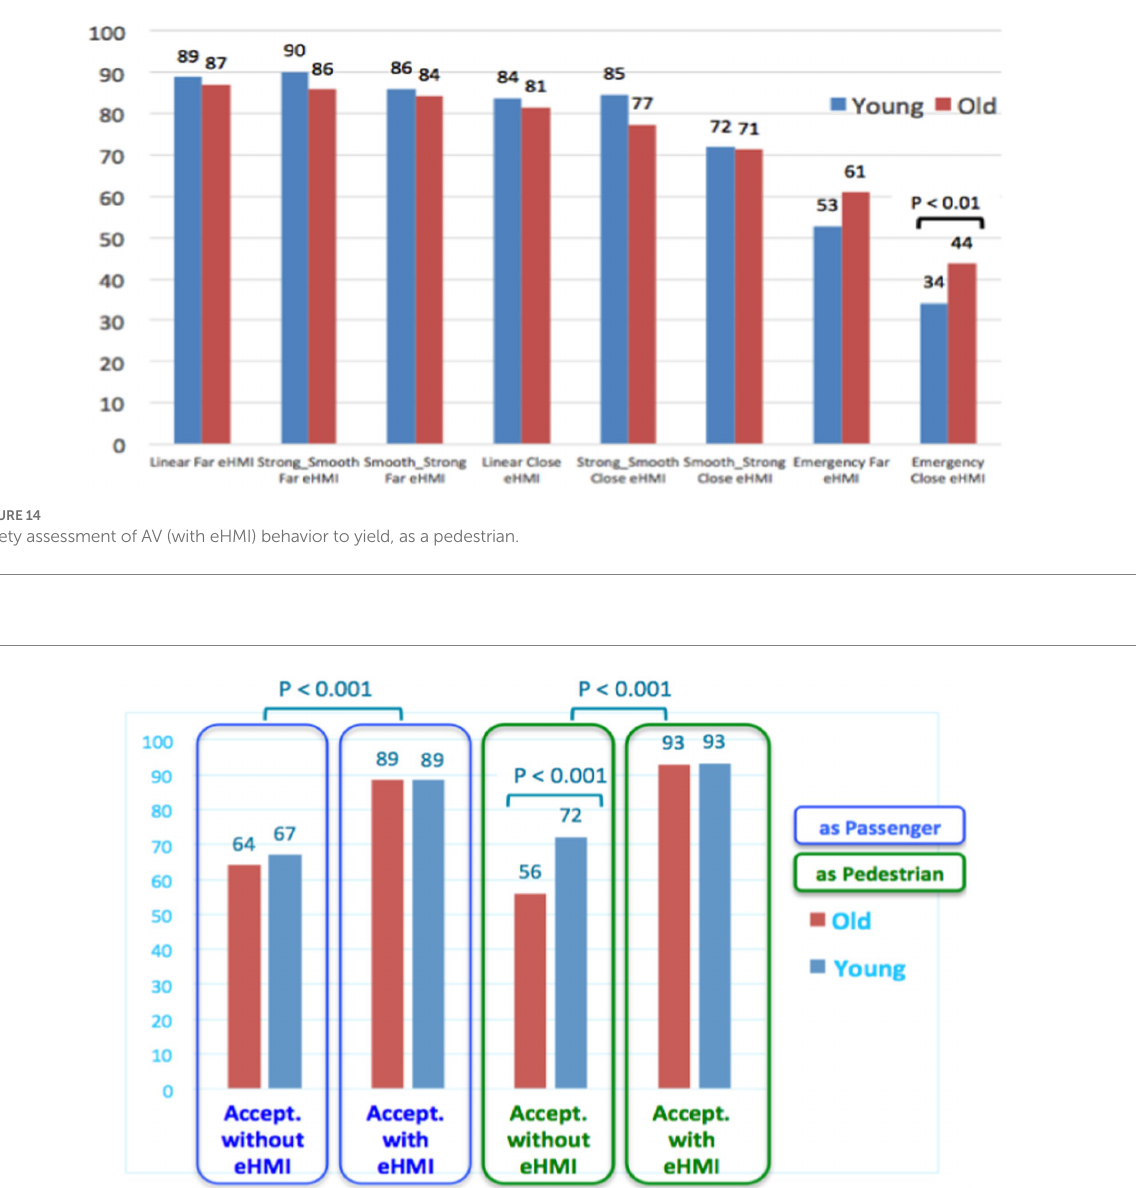
FIGURE 15 Effect of the eHMI on acceptance of